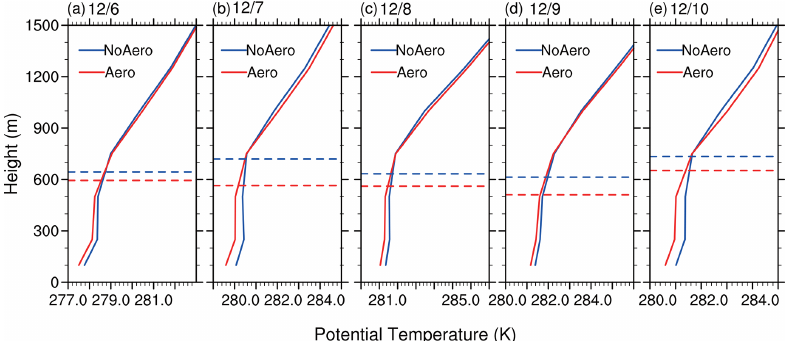
Figure 14. NCP (defined in Fig. 1a) area-averaged vertical profiles of potential temperature (K, solid) and planetary boundary layer height (m, dash) in NoAero (blue) and Aero (red) at 14:00LT on (a) 6 December, (b) 7 December, (c) 8 December, (d) 9 December and (e) 10 Decem- ber